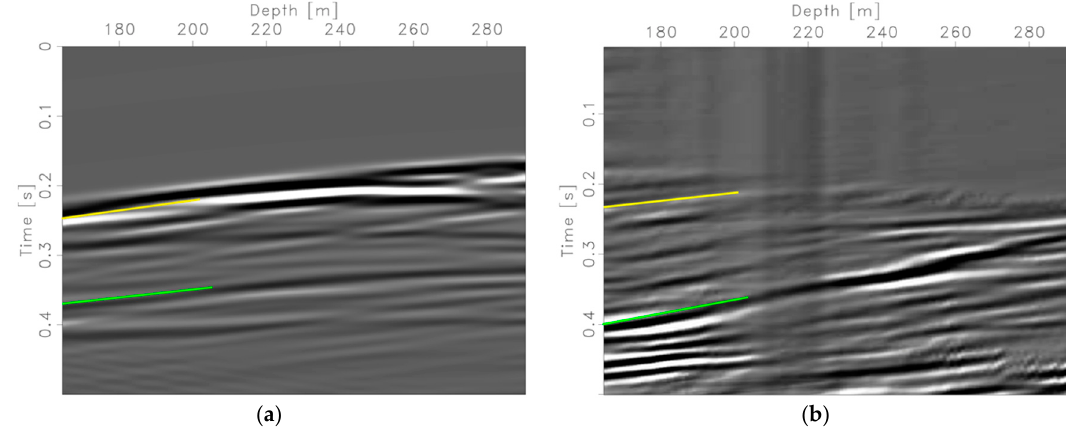
Figure 5. Vibe point 125: ( a ) synthetic P-S data via Born approximation/modeling and reflectivity of the 4 faults model [10] and ( b ) observed data filtered for only upgoing events (same as in Figure 3b).